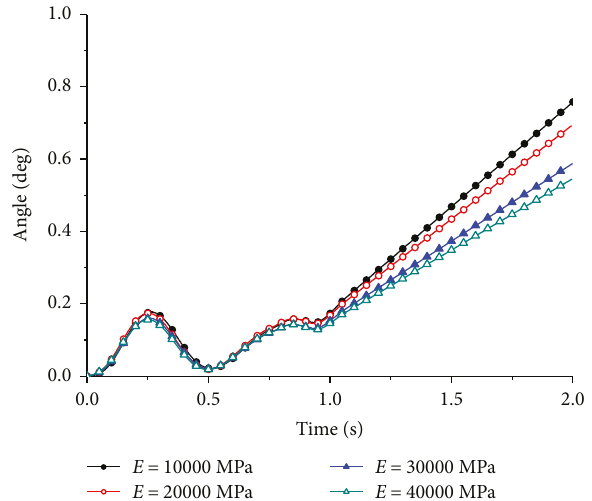
Figure 24: Pitch angle of the missile at di ff erent elastic modulus.